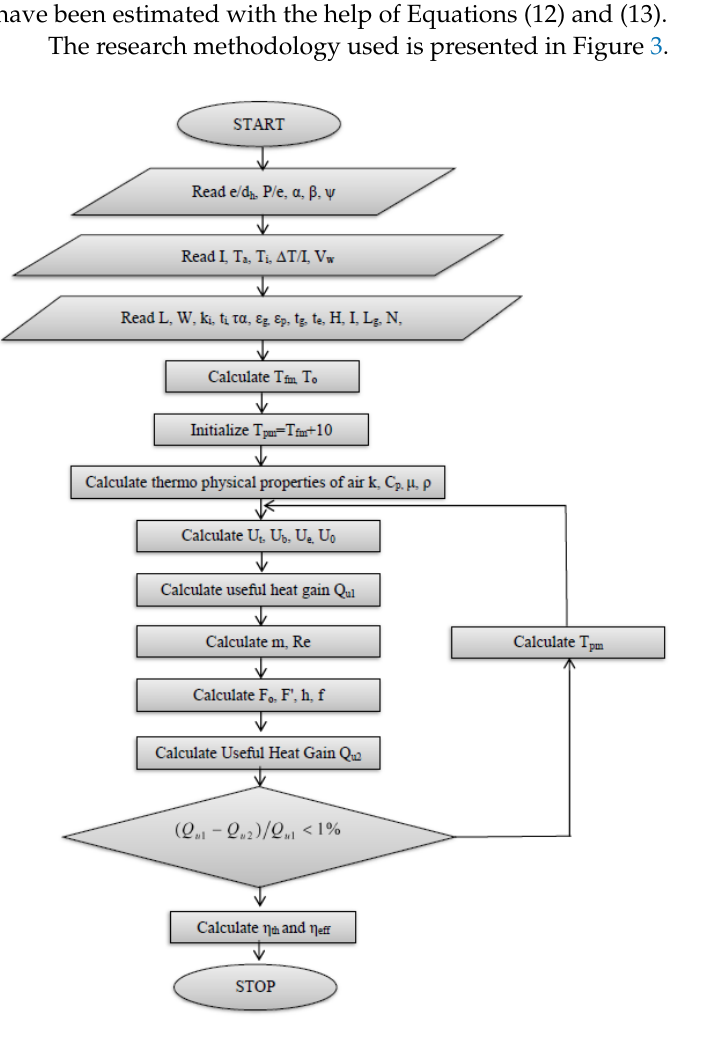
Figure 3. Flow chart of methodology.